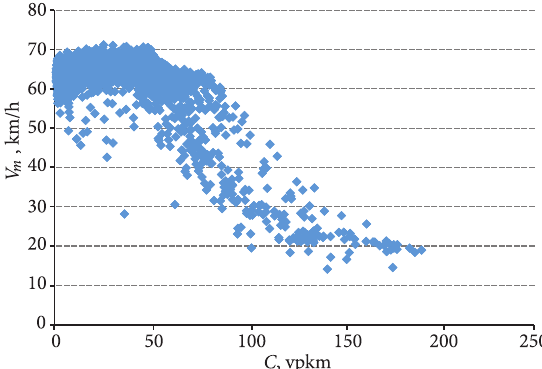
Fig. 4. Relation of 95% average momentary speed and traffic flow density